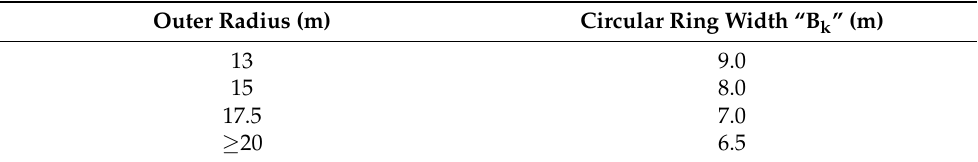
Table 1. Circular ring width (“B k ”) depending on the outer radius [9].